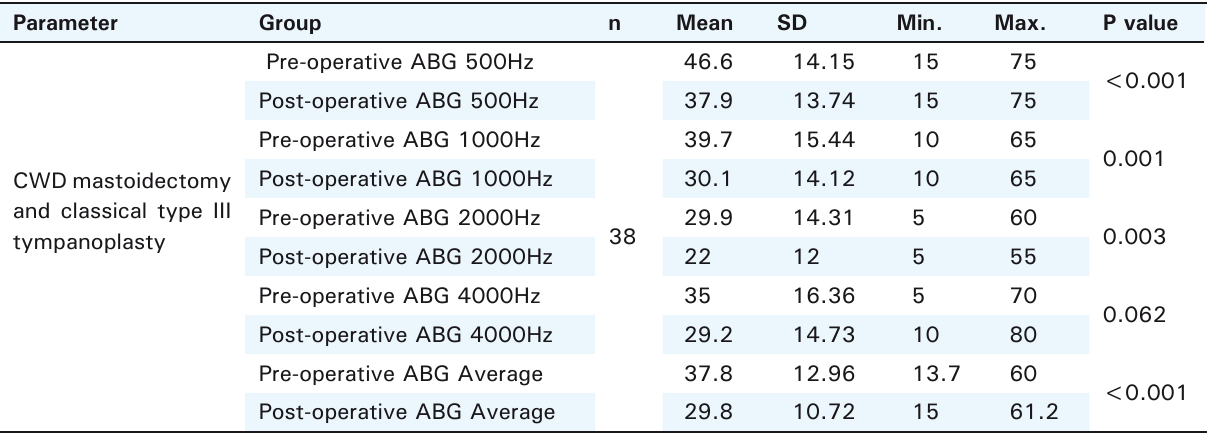
table 4. AbG closure in classical type III tympanoplasty (n=38) Group CWD